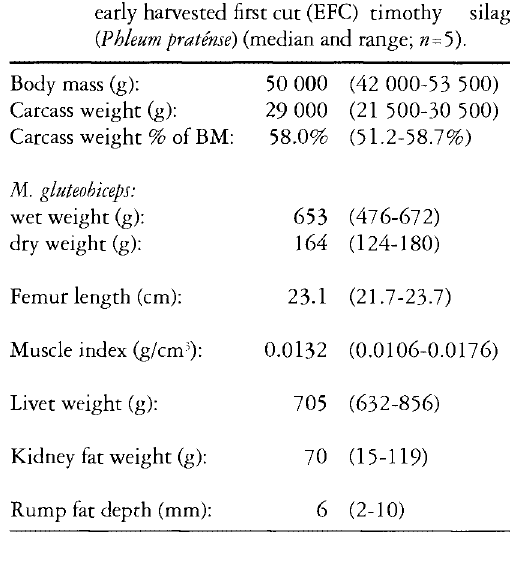
Table 2. Body composition of male reindeer calves